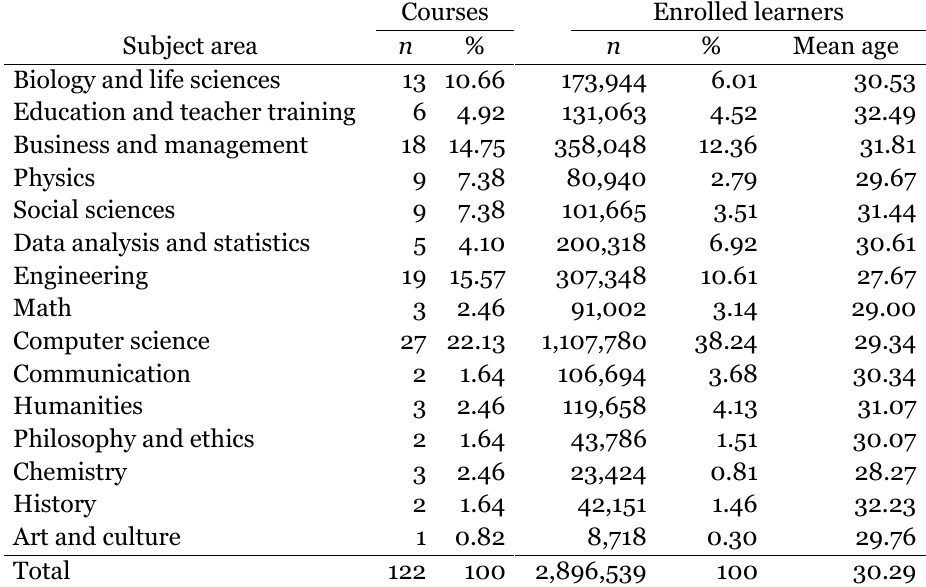
Number of Courses According to Subject